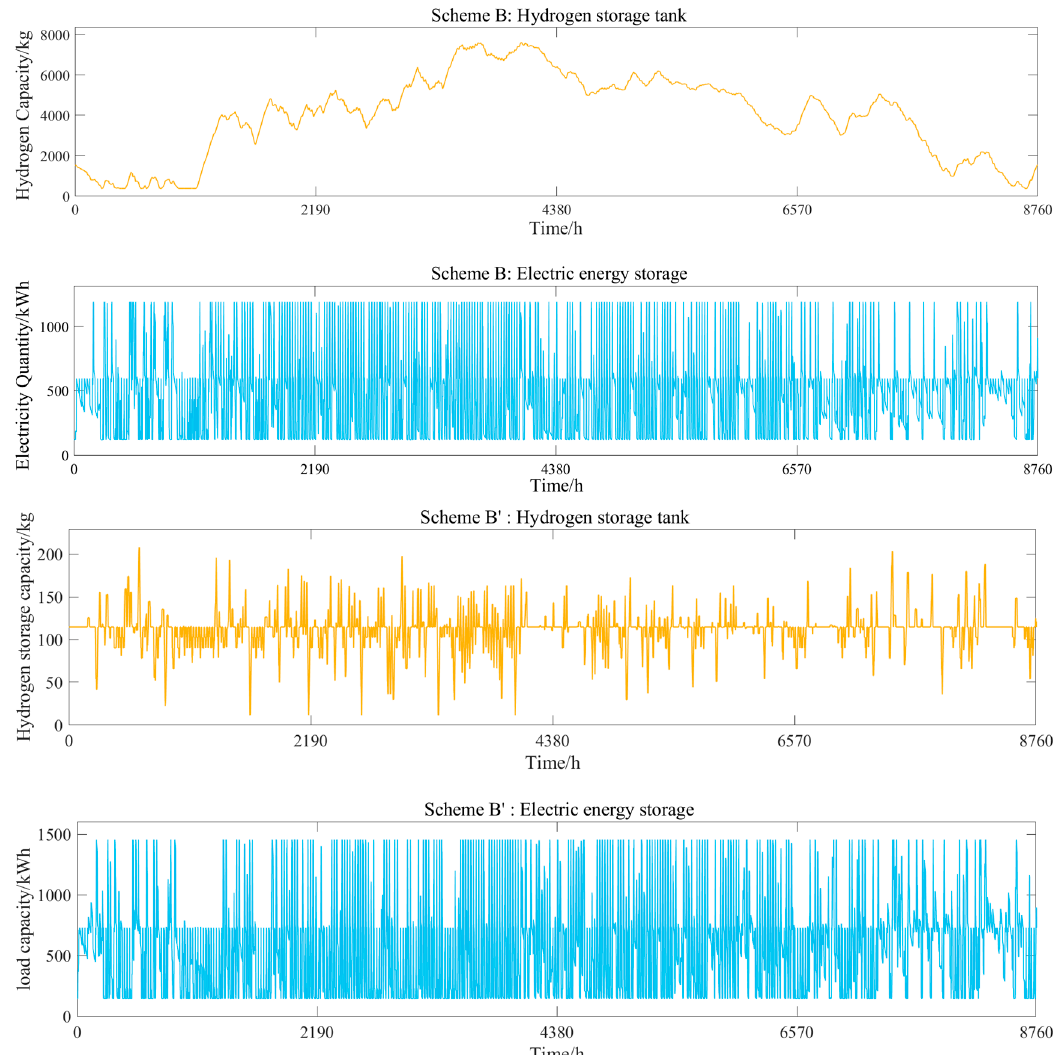
Figure 7. Annual reserve change of electric energy storage and hydrogen storage tanks in two schemes.